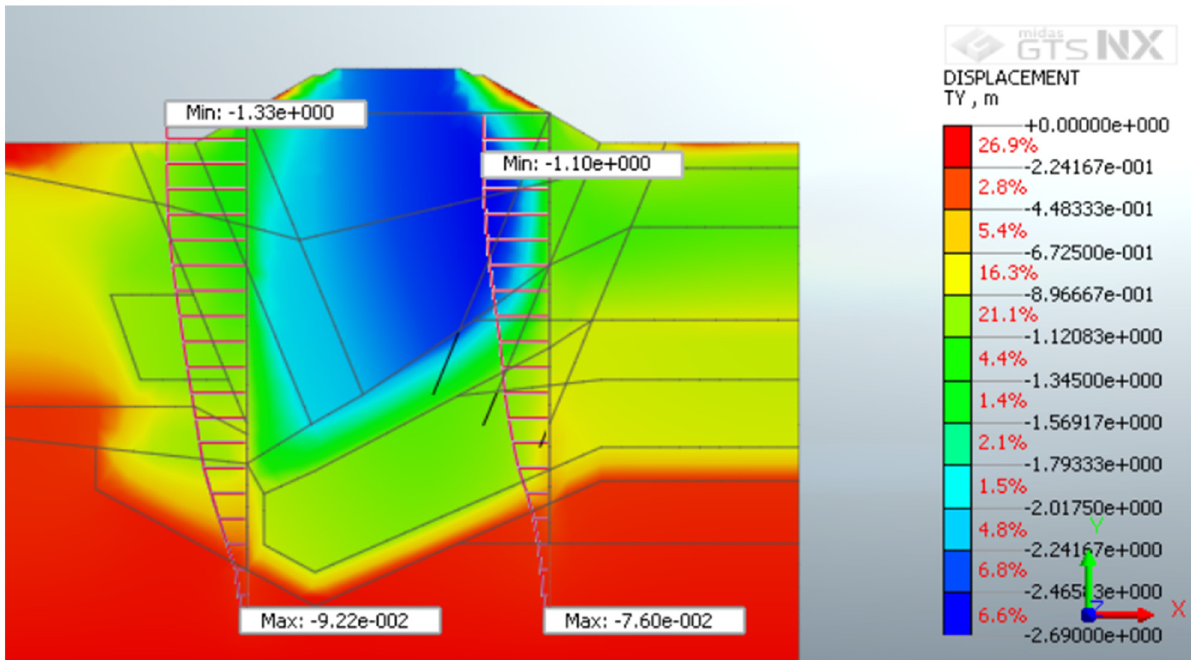
Figure 17: Vertical displacement map of weakened soils with the weakening e ff